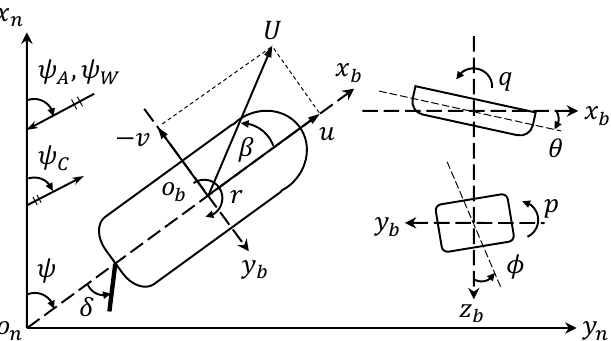
Figure 1. Coordinate systems.